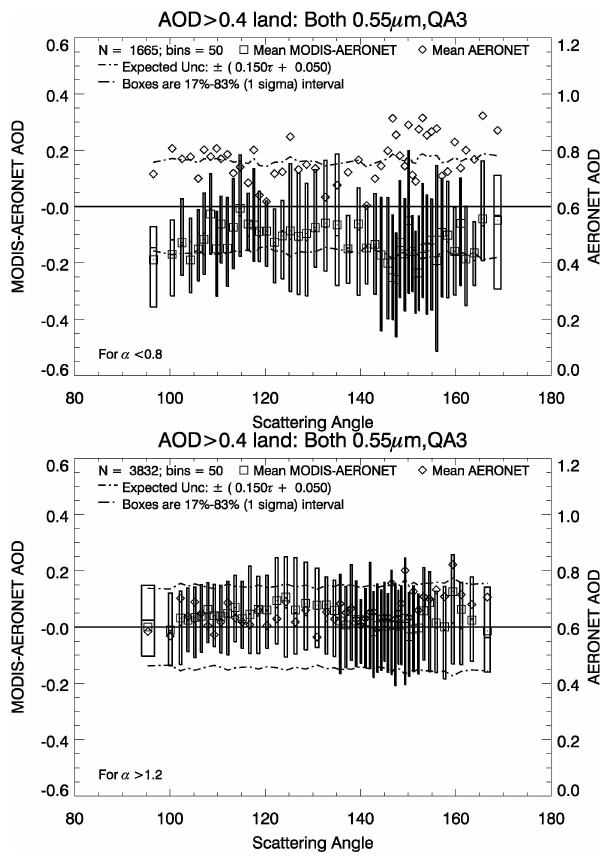
Fig. 13. Differences between MODIS and AERONET-reported AOD at 0.55µm (MODIS-AERONET) vs. MODIS-observed scat- tering angle, for QAC=3, for the “heavy” ( τ > 0 . 4) aerosol loading cases only, now separated by AERONET-reported ˚Angstrom expo- nent. The top/bottom panels represent cases with “large” ( α < 0 . 8) and “small” ( α > 1 . 8) values of AE. The explanation of symbols is given in Fig. 6.